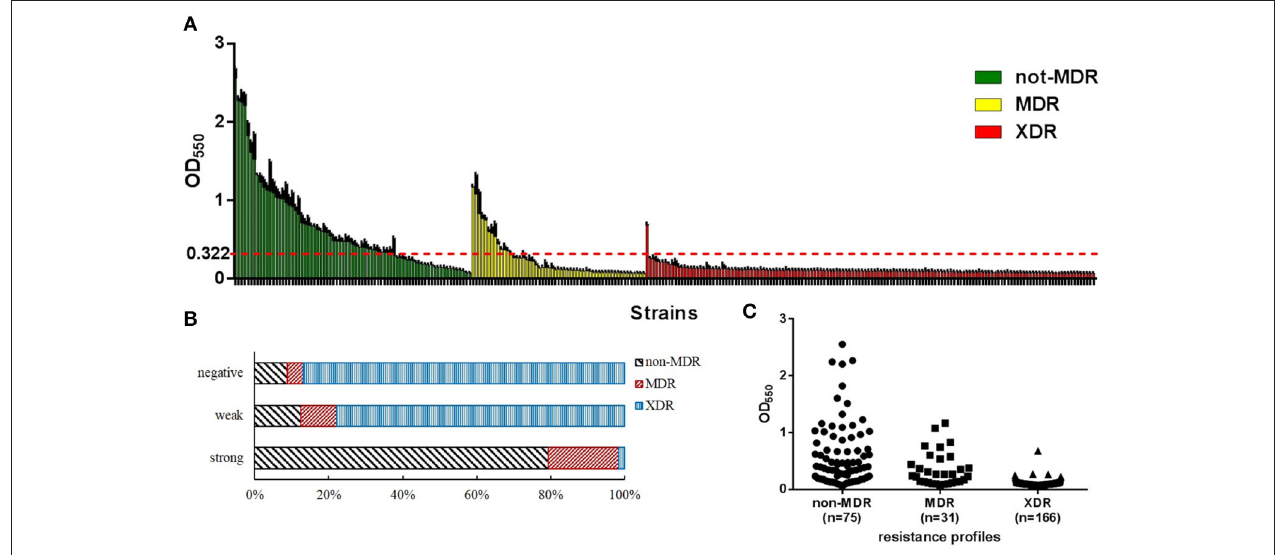
FIGURE 2 | Biofilm formation of A. baumannii isolates examined in this study. OD 550 , optical density at 550 nm, represents biofilm forming capacity. (A) The level of biofilm formation was assessed for each isolate. Strains were divided into three groups according to their antibiotic resistance phenotypes: non-multidrug-resistant (non-MDR), multidrug-resistant (MDR), and extensively drug-resistant (XDR). The red line shows the optical density at 550 nm (OD 550 ) of the biofilm biomass produced by the reference strain (ATCC 19606). Larger proportion of non-MDR isolates tended to form stronger biofilms (higher OD 550 values). (B) Distribution of resistance phenotypes among different biofilm production capacities displayed as a percentage stacked bar graph. Population that exhibited more robust biofilm formation likely contained larger proportion of non-MDR isolates. (C) Distribution of biofilm formation of isolates with different resistance phenotypes. Isolates with higher level of resistance tended to form weaker biofilms.